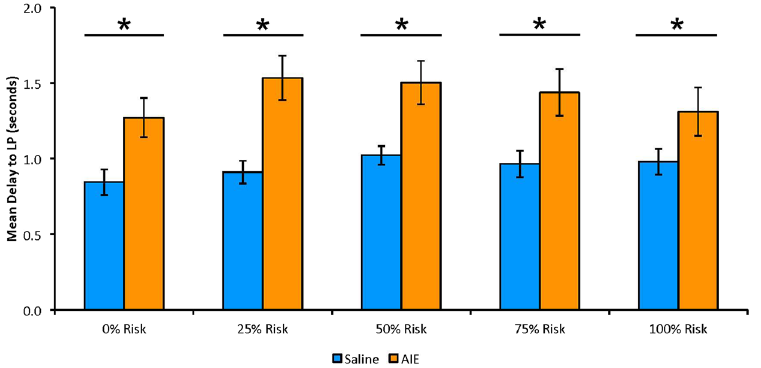
Figure 4. Mean ( ± SEM) delay to lever press (LP), regardless of lever choice, in choice trials at each risk level, averaged across all days of testing (days 1–20). Maximum potential delay to lever press is 10 s. AIE results in increased delay time at each of the 5 risk levels. * = p ≤ 0.01. Statistics: Multiple t-tests, Bonferonni correction − 0% Risk: F(1,14) = 7.52, p = 0.008; 25% Risk: F(1,14) = 14.34, p = 0.001; 50% Risk: F(1,14) = 9.48, p = 0.004; 75% Risk: F(1,14) = 7.13, p = 0.009; 100% Risk: F(1,14) = 3.31, p = 0.045.